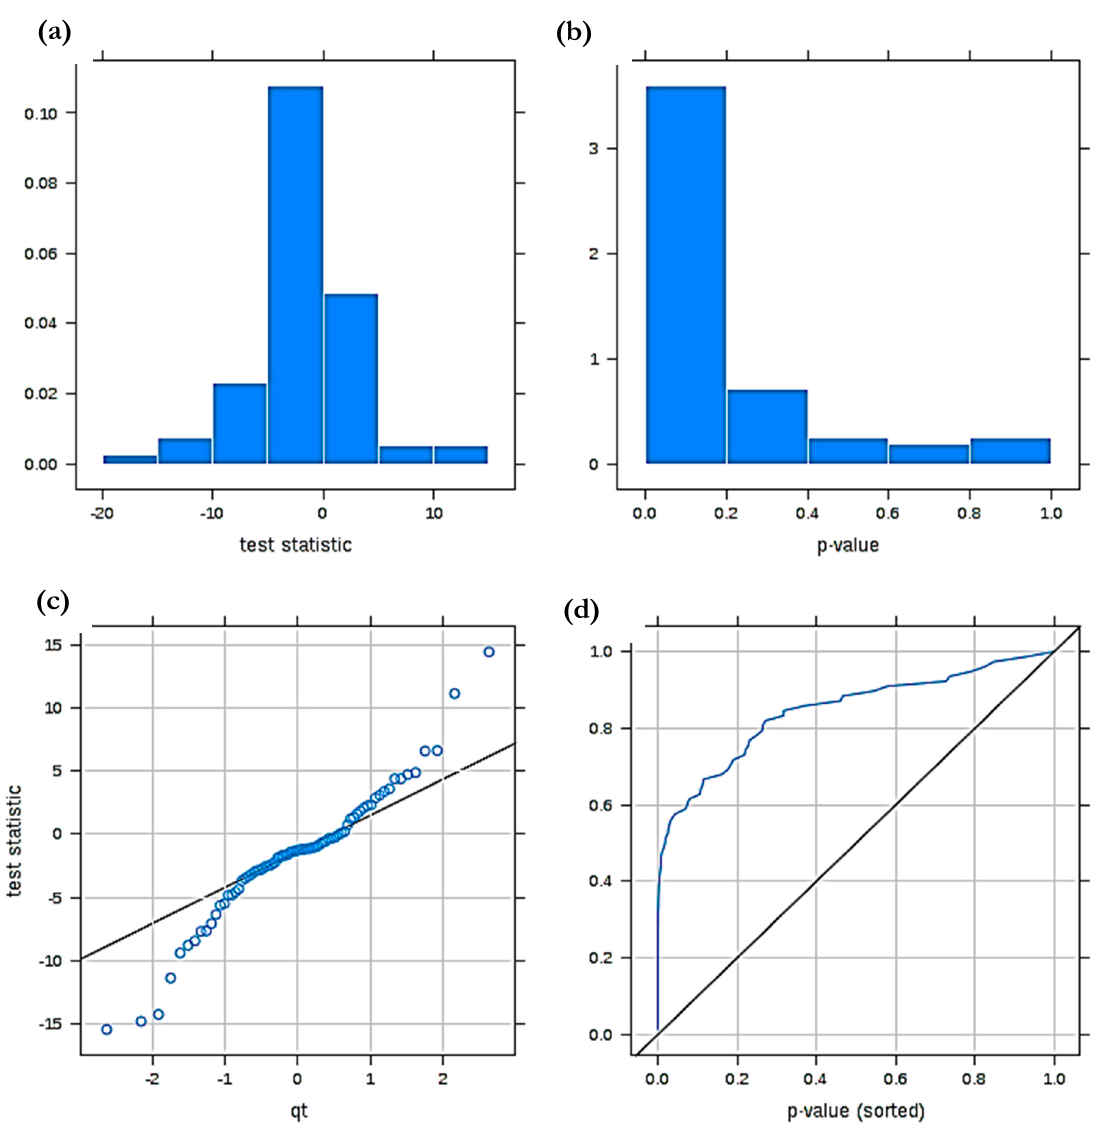
Figure 4. Diagnostic plots derived from a MV statistical power calculation conducted on a model involving comparisons between the 1 H NMR profiles of human blood plasma collected from healthy humans (controls) and GM1 type II gangliosidosis patients. ( a ) t statistic value p value distribution displayed as a histogram; ( b ) corresponding QQ plot of these t -test values (i.e., t versus qt value); ( c ) left-shifted distribution of t-test statistic p values for this power analysis; ( d ) plot of sorted t statistic p values versus their ranking. The dataset was constant-sum normalised, cube root-transformed and Pareto-scaled prior to analysis.